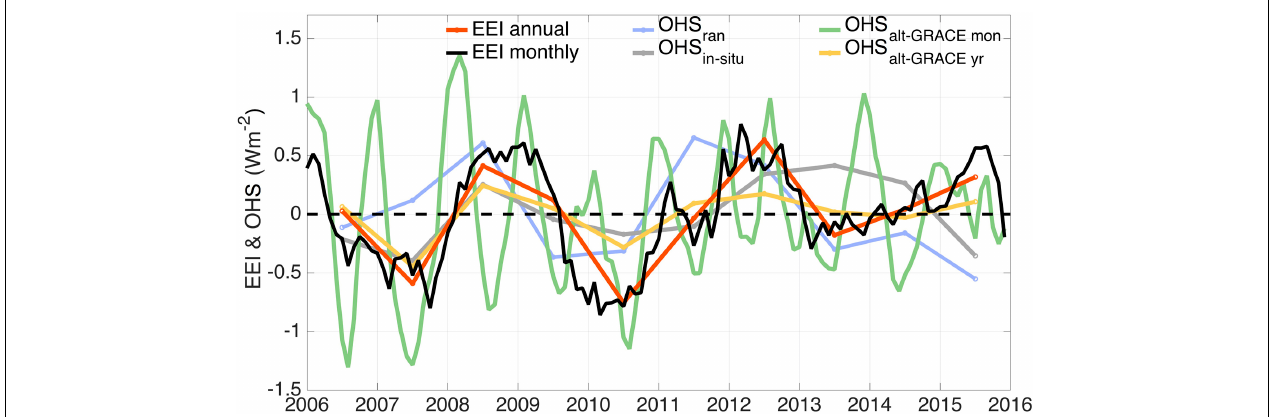
FIGURE 12 | EEI (CERES EBAF) and OHS (dOHC/dt) timeseries from ocean reanalysis (OHS ran), in situ estimation (OHS in situ ), and alti-GRACE (OHS alti-GRACE). We show annual timeseries for all parameters (with long-term mean removed) and deseasonalized monthly anomalies for OHS alti-GRACE and EEI that have been smoothed applying a 5-months running average